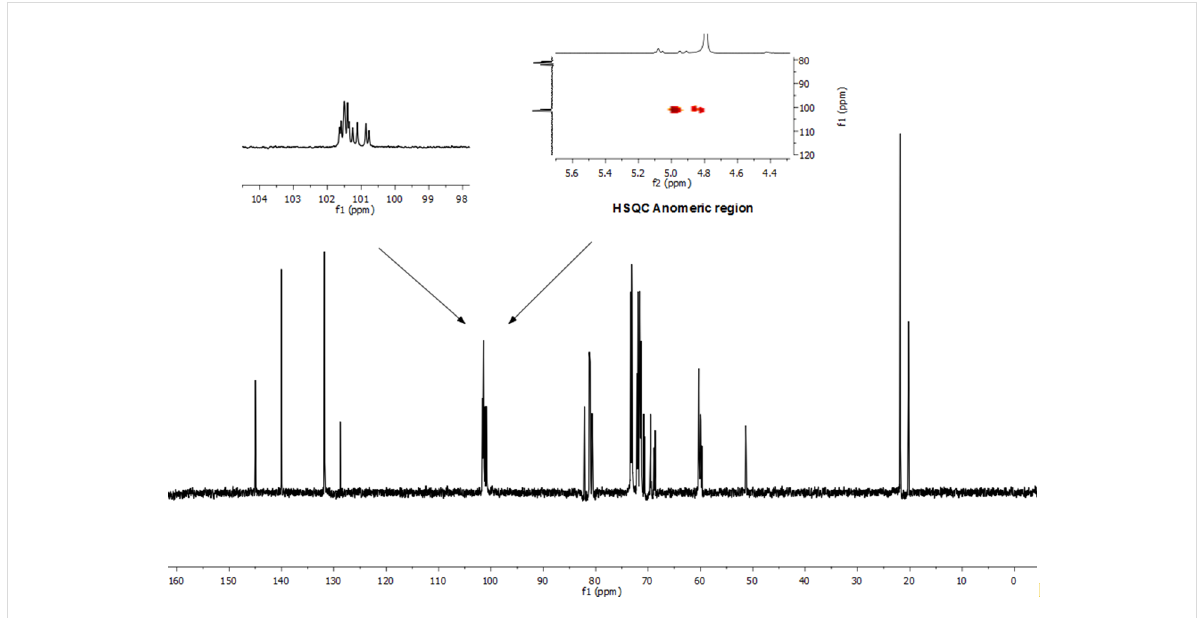
Figure 6: 13 C NMR spectrum of the AC regioisomer 8c as a mixture of pseudoenantiomers prepared through reaction 6 (D 2 O, 125 MHz).